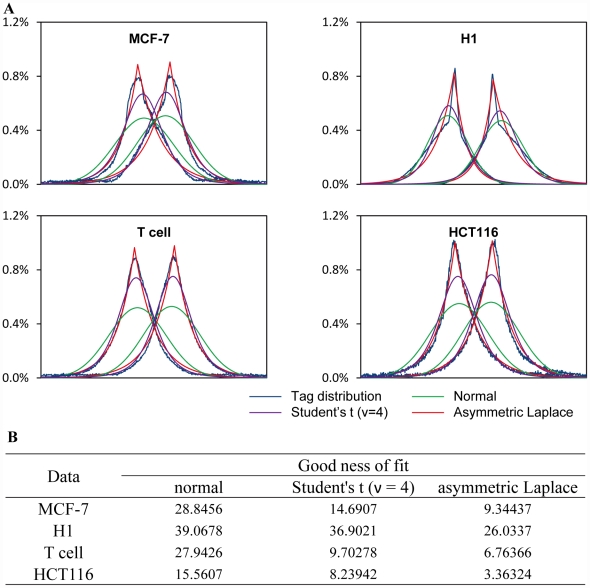
Bi-asymmetric-Laplace model.A. A plot of tags density surrounding the methylated CpG sites of MCF-7 MBD-seq and three public MBD-seq data in H1, T cell and HCT116 cell respectively (blue) and the fitted normal distribution (green), Student's t (ν = 4) distribution (purple) and bi-asymmetric-Laplace distribution (red). B. Asymmetric Laplace distribution gained smaller value of goodness of fit over the distribution of tags than normal distribution and t-distribution with 4 degree of freedom, indicates BALM captures the bimodal pattern more precisely.